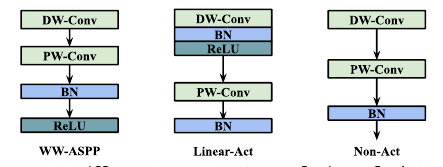
Figure 11. Different DW-PW Convolution Block Design